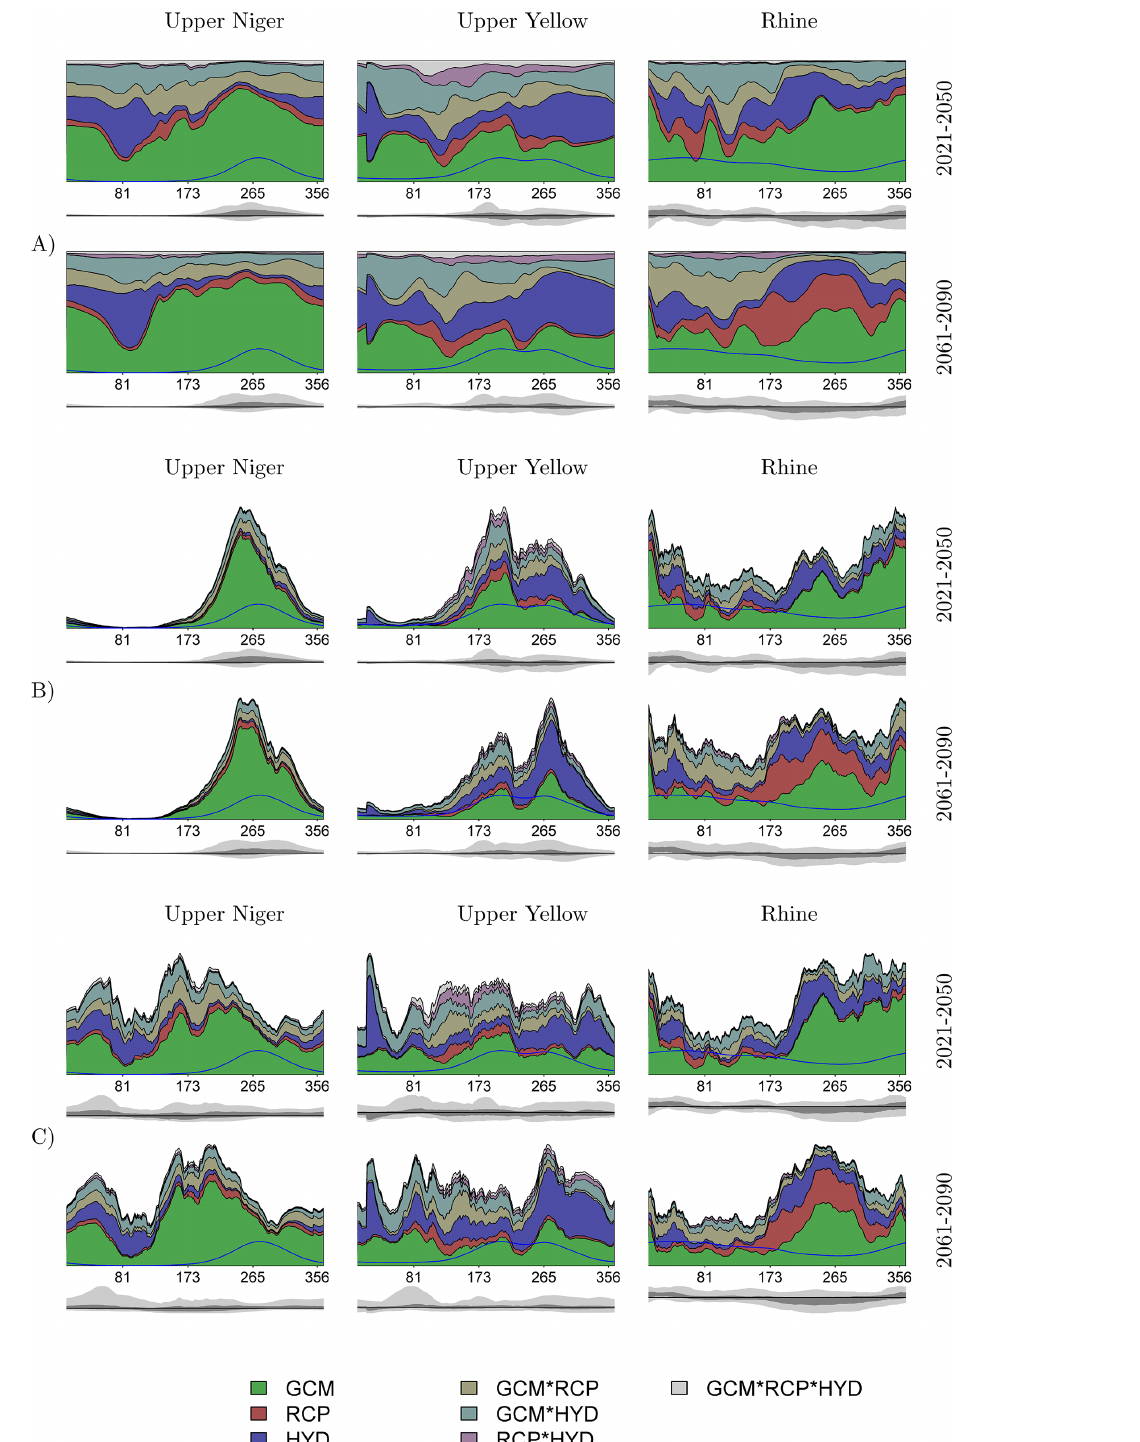
Figure 11. Contribution of different sources of uncertainties to the overall uncertainty in the projected long-term average seasonal dynamics for the Upper Niger, Upper Yellow and Rhine basins for two scenario periods. The blue line denotes the long-term average runoff in the reference period. (a) Unscaled results; (b) results scaled by variability (interquartile range) of absolute changes in river discharge; (c) results scaled by variability (interquartile range) of relative changes in river discharge. Ranges (light gray) and interquartile ranges (dark gray) of projected absolute changes (a, b) and projected relative changes (c) are given below each colored